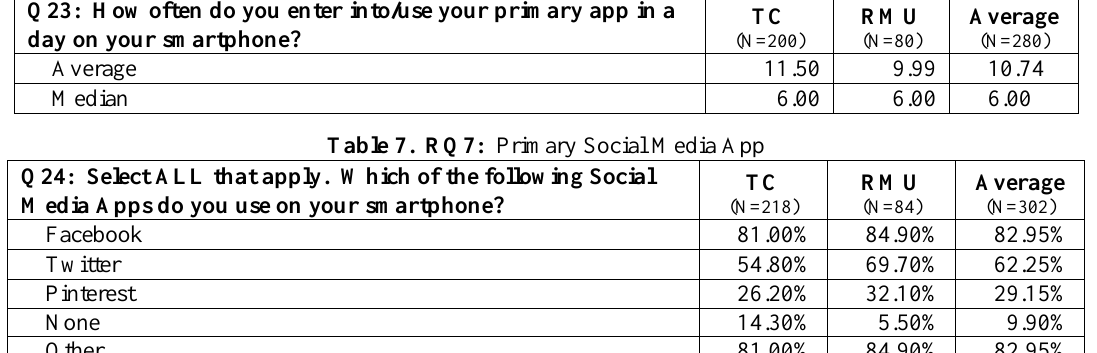
Table 6. RQ6: App most frequently used